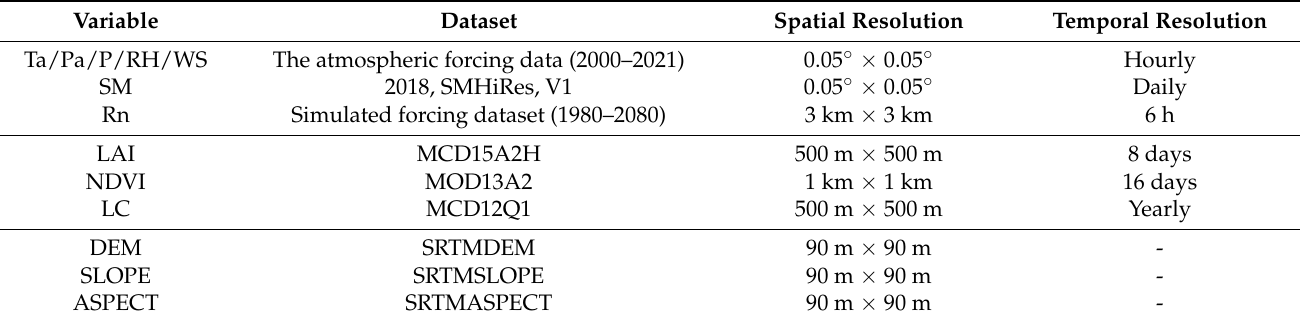
Table 4. Input datasets used to drive the machine learning